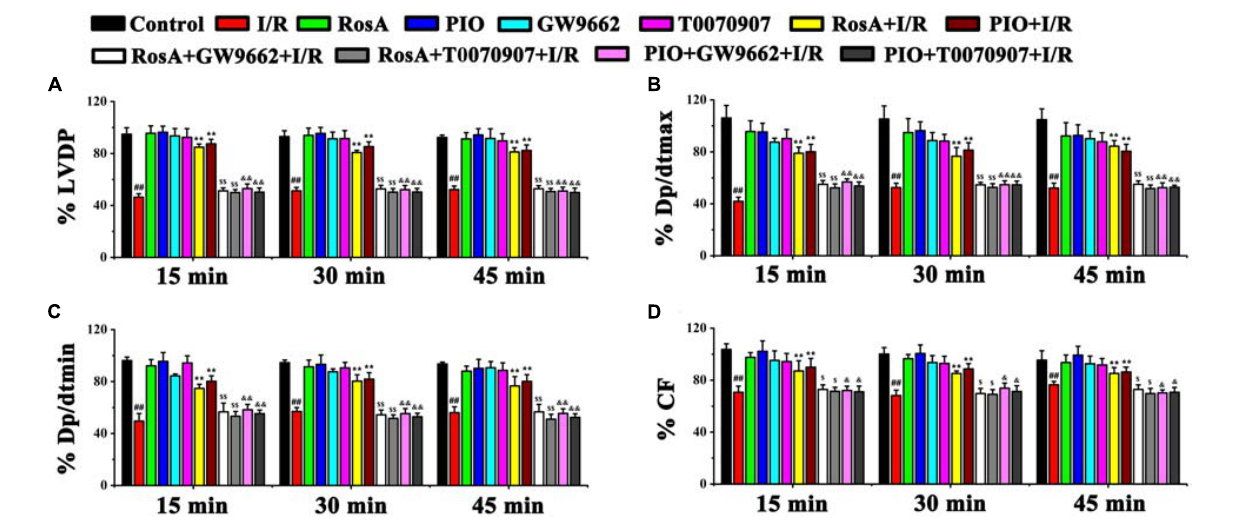
FIGURE 1 | The effect of RosA on cardiac function in rat I/R model. The effect of RosA on LVDP (A) , dp/dtmax (B) , dp/dtmin (C) , and CF (D) in rat hearts. Control, healthy control mice; I/R, ischemia/reperfusion model mice; RosA, healthy mice treated with RosA; PIO, healthy mice treated with pioglitazone; GW9662, healthy mice treated with GW9662; T0070907, healthy mice treated with T0070907; RosA+I/R, I/R mice treated with RosA; PIO+I/R, I/R mice treated with PIO; RosA+GW9662+I/R, I/R mice treated with RosA plus GW9662; RosA+T0070907+I/R, I/R mice treated with RosA plus T0070907; PIO+GW9662+I/R, I/R mice treated with PIO plus GW9662; PIO+T0070907+I/R, I/R mice treated with PIO plus T0070907. Values are presented as means with their standard deviation, n = 6. Compared with the control group, # P < 0.05, ## P < 0.01. Compared with the I/R group, ∗ P < 0.05, ∗∗ P < 0.01. Compared with the I/R+RosA group, $ P <